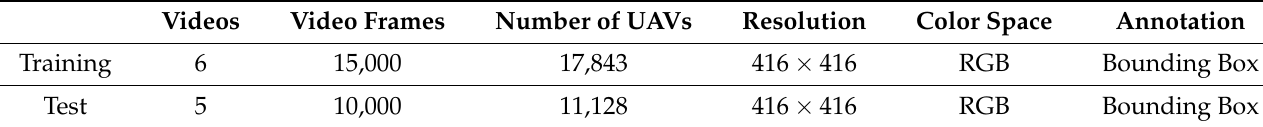
Table 3. Attributes of UAV-UAV